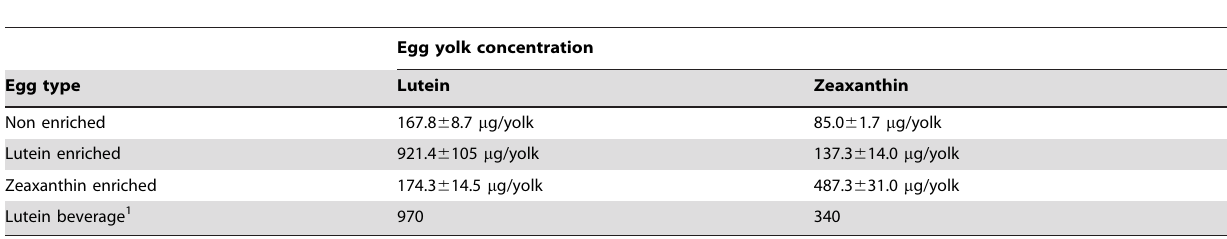
Table 1. Lutein and zeaxanthin content of egg yolks (mean 6 standard